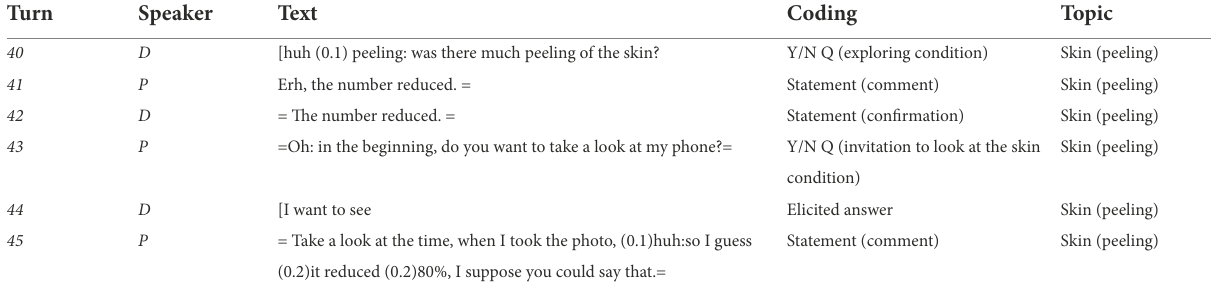
TABLE 3 First example of communicating uncertainty to achieve consensus: past problems and future